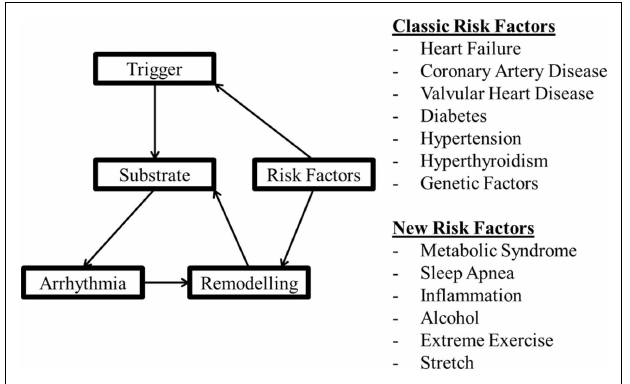
FIGURE 2 |A model of factors involved in arrhythmogenesis and the effect of remodeling with the classical and more recent factors thought to be involved in arrhythmia